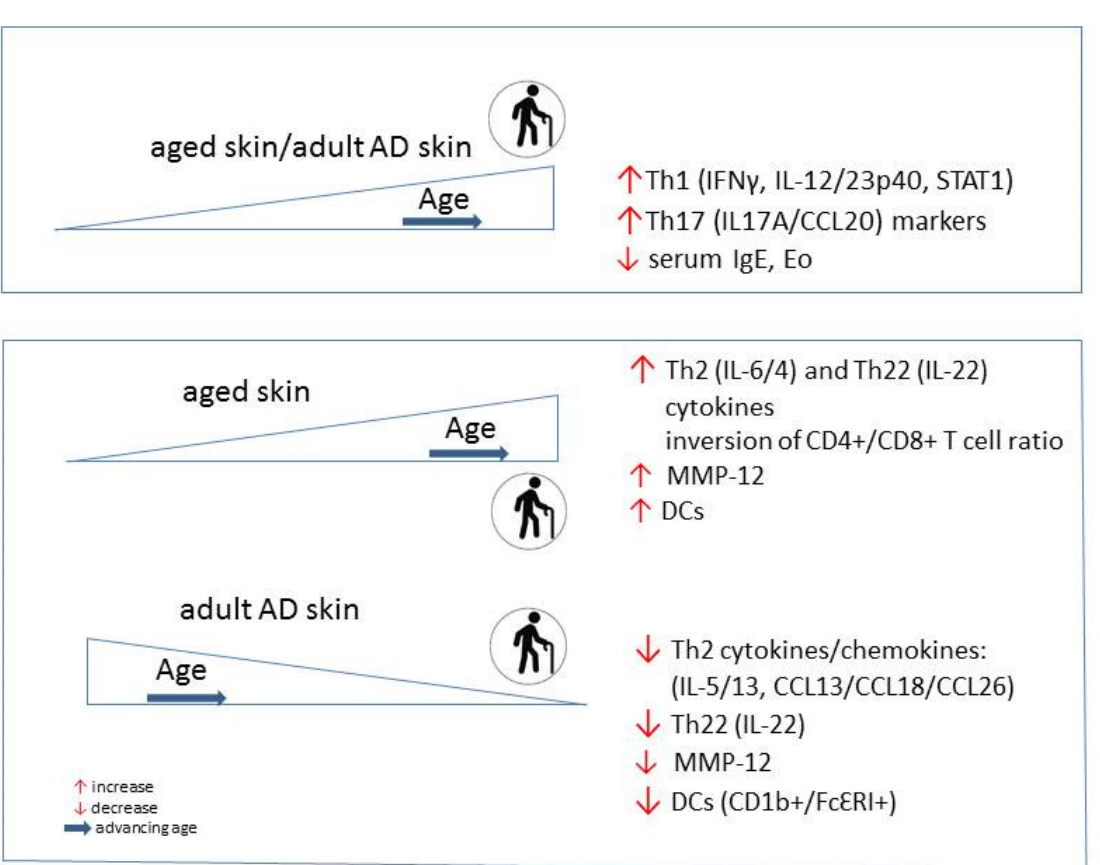
Figure 2. Skin-specific immunological properties of the healthy vs. AD population change during aging.